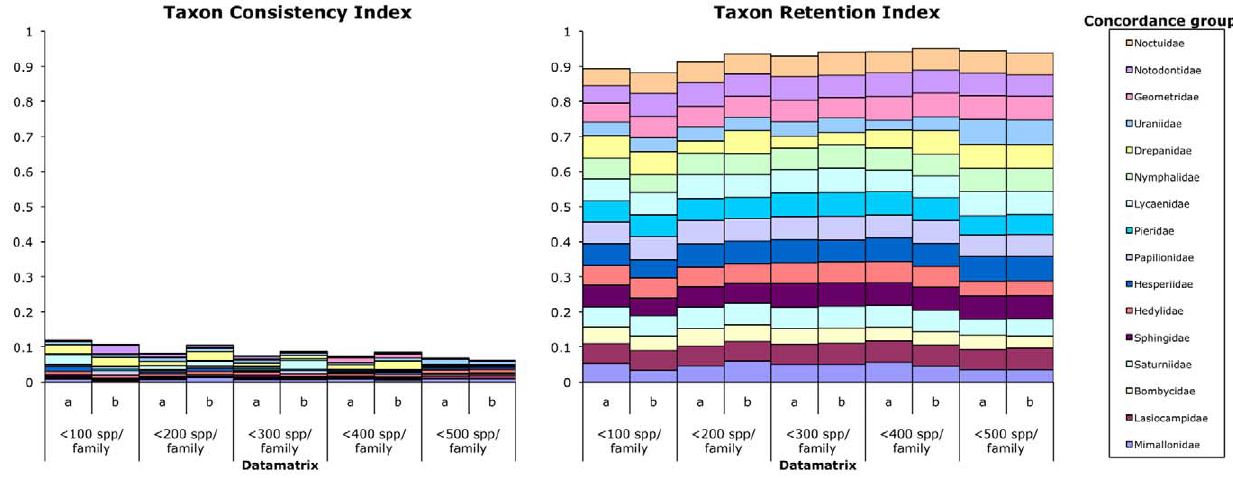
Figure 3. Phylogenetic signal scores. The bars are coloured to show the relative contribution to the score by each of the concordance groups.